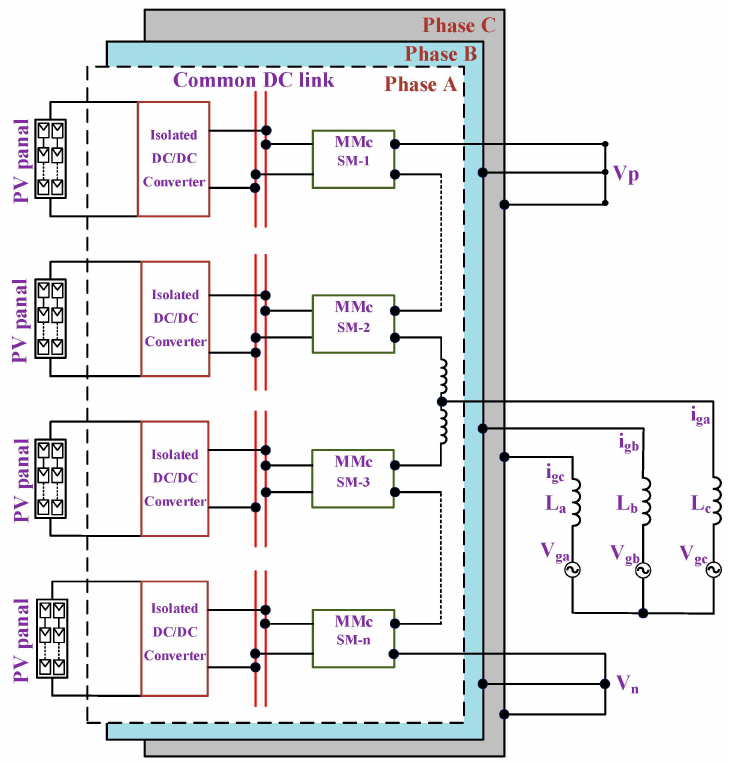
Figure 13. An MMC with an isolated DC converter [79].